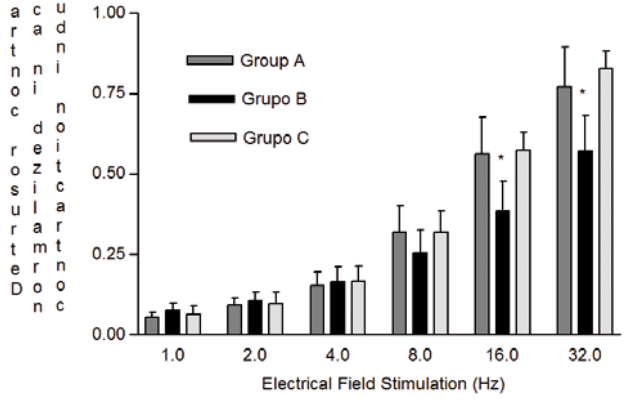
Group A: sham; Group B: obstructed; Group C: obstructed + galangin. * p < 0.05.